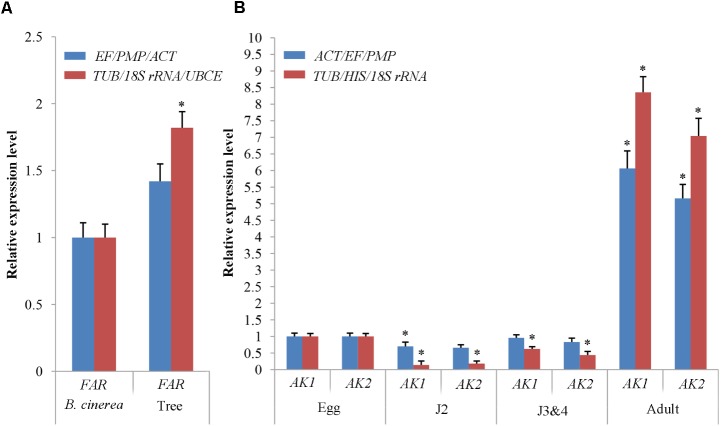
Evaluation of reference genes using (A) the fatty acid- and retinol- binding protein gene (FAR) under both habitat conditions and (B) the arginine kinase genes (AK1 and AK2) in all developmental stages with the three most stable reference genes and the most unstable reference gene. The expression levels of FAR in Botrytis cinerea
(A) and of AK1, AK2 in the eggs (B) were set at a relative expression of 1 (control). Data points indicate the mean ± SE calculated from three biological replicates. The asterisks indicate statistically significant differences (p < 0.05) from the control.